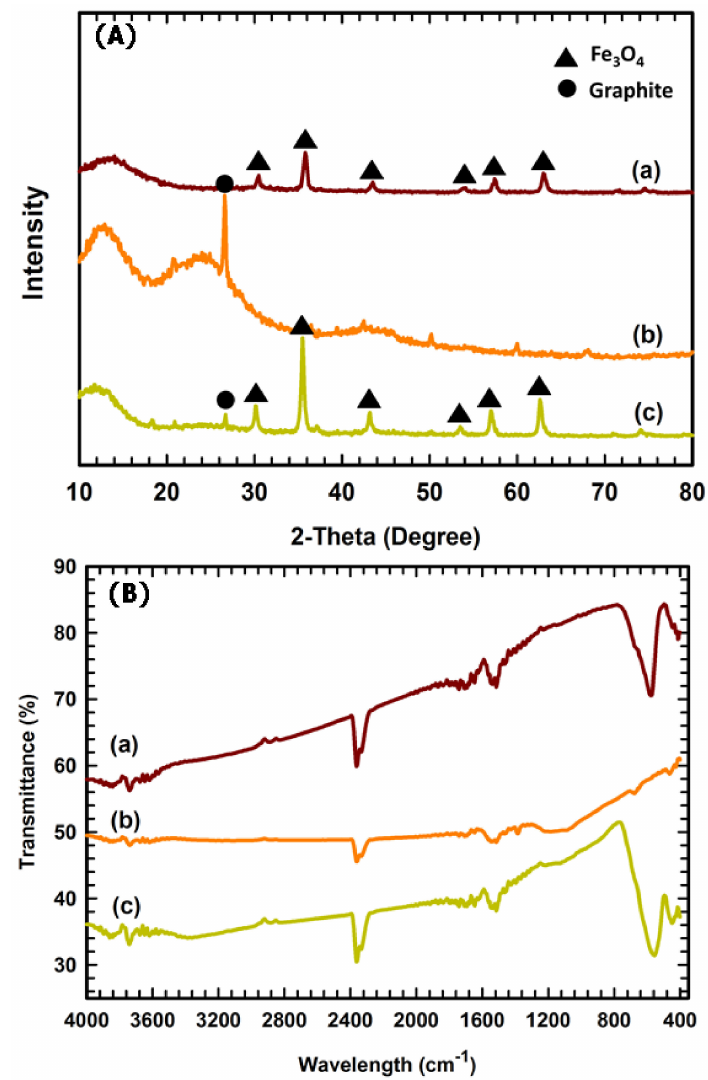
Figure 2. ( A ) X-ray diffraction ( XRD) and ( B ) Fourier transform infrared (FTIR) patterns of (a) Fe 3 O 4 , (b) WB, and (c) Fe 3 O 4